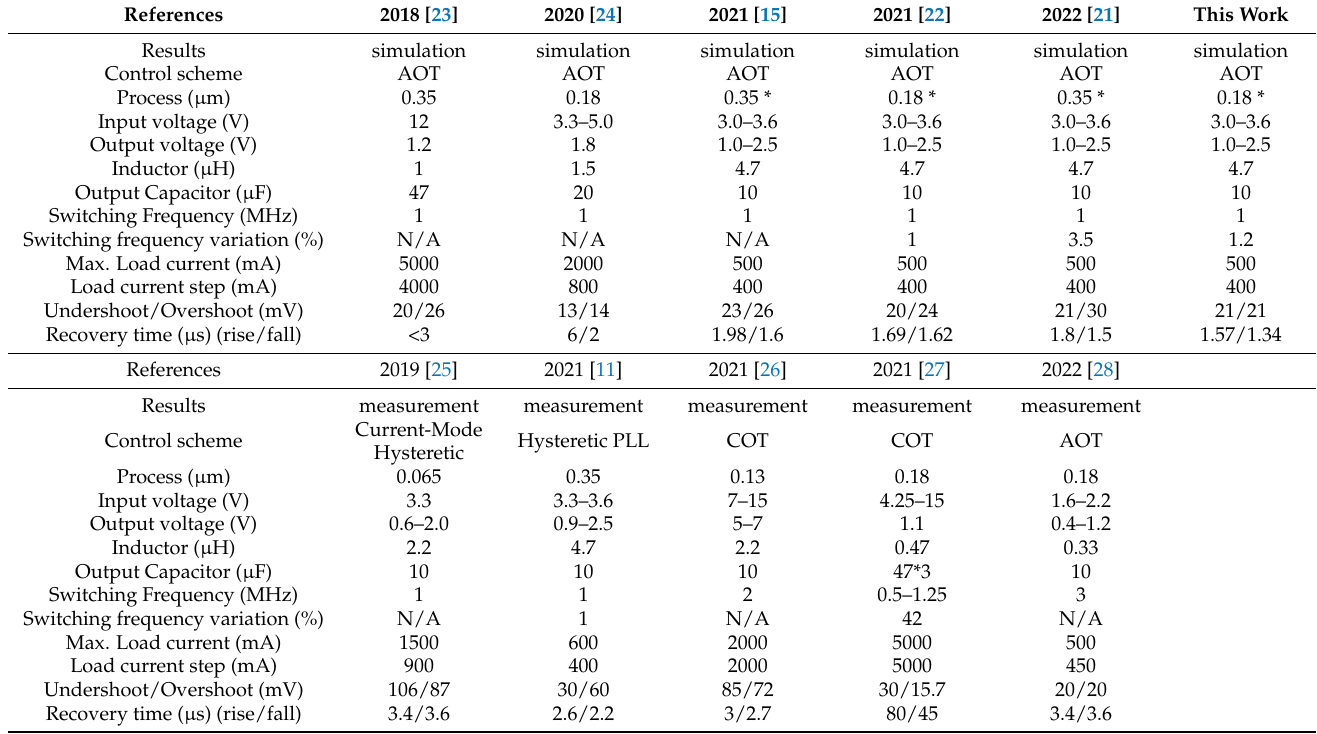
Table 3. Performance Comparisons with Reported